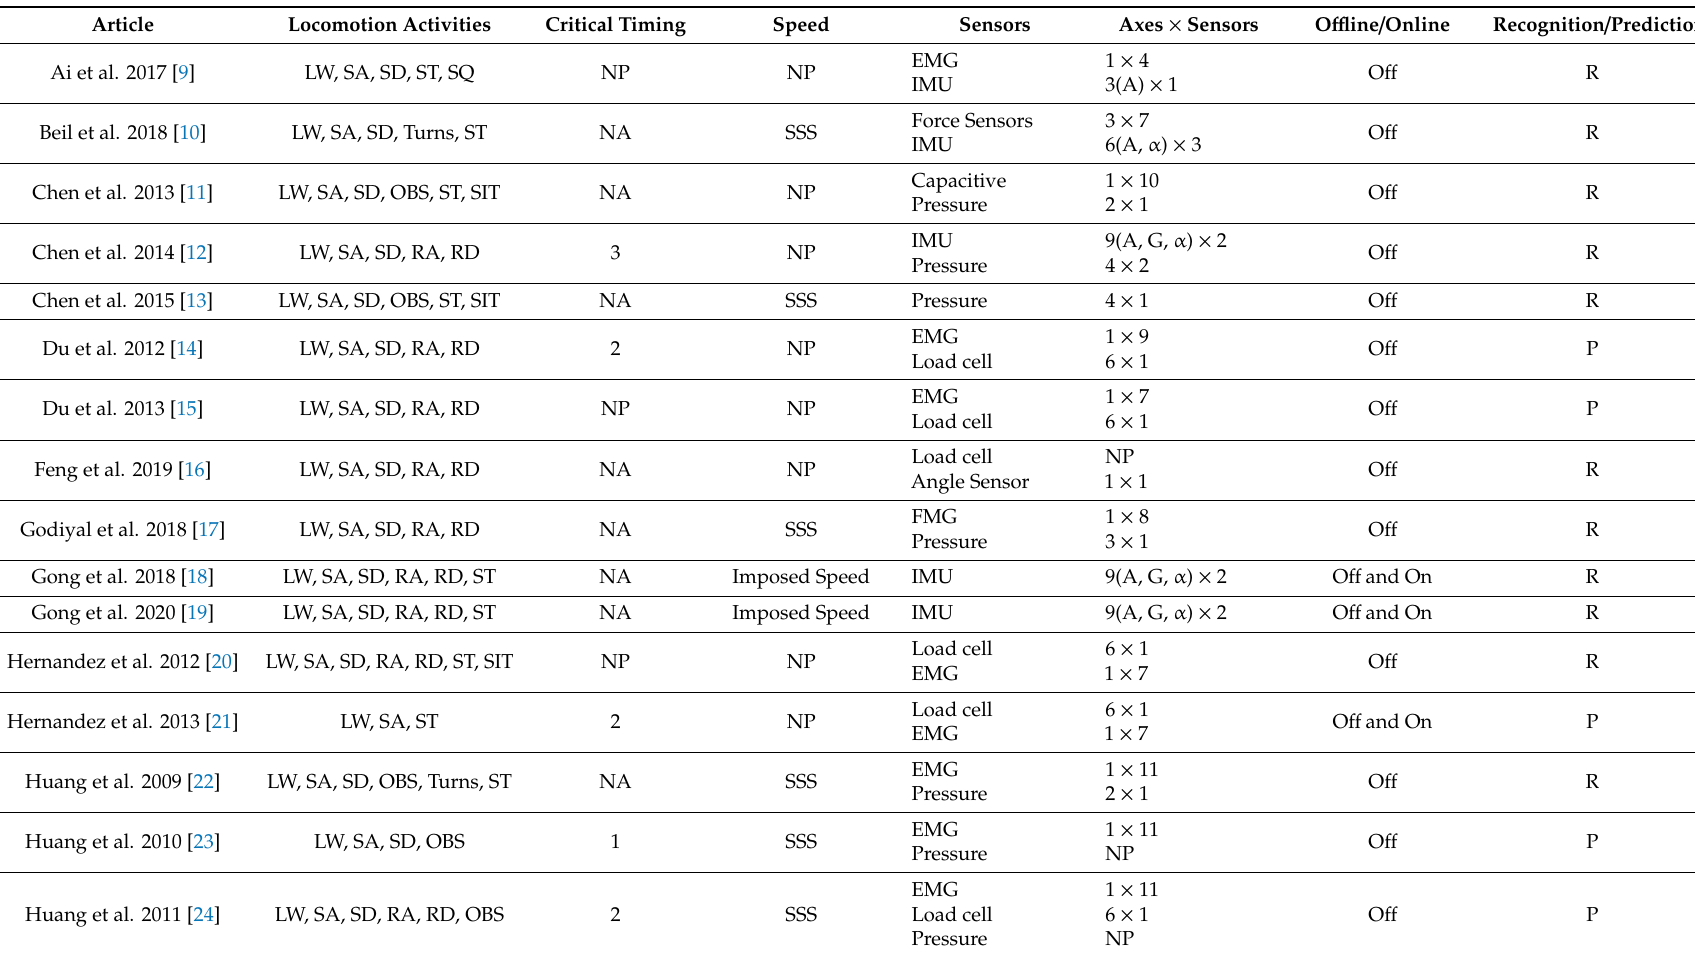
Table 2. Sensors used for recognition and / or prediction of the locomotion activities investigated in the included